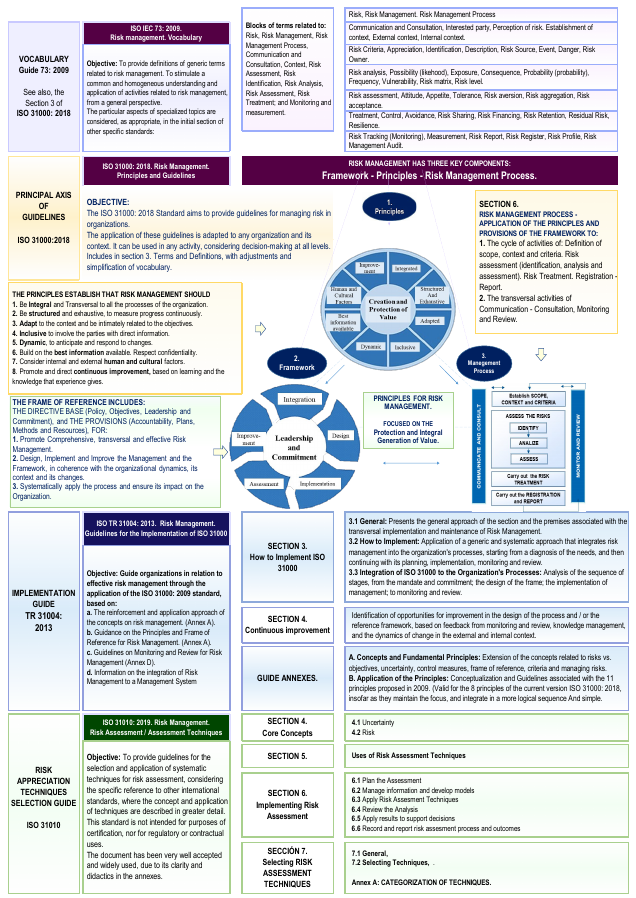
Figure A1. Approach and Logical Structure of the ISO 31000 Family of Standards. [14,20,50,51,65,66].